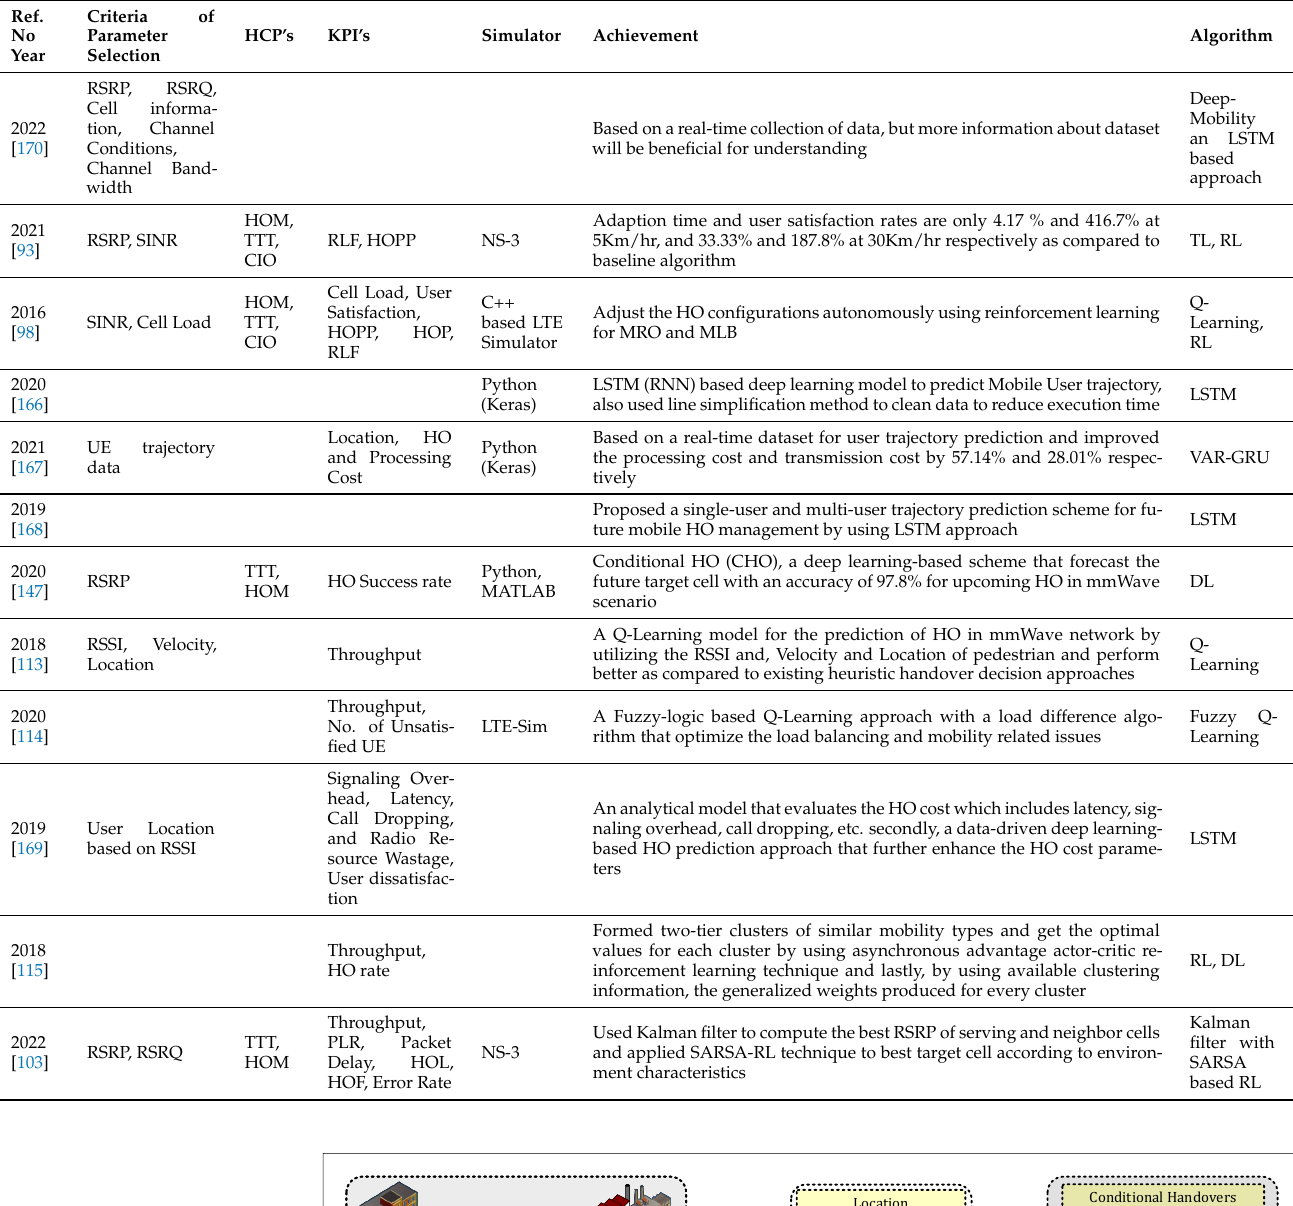
Table 9. Summary of Handover Decision Approaches based on ML/DL.